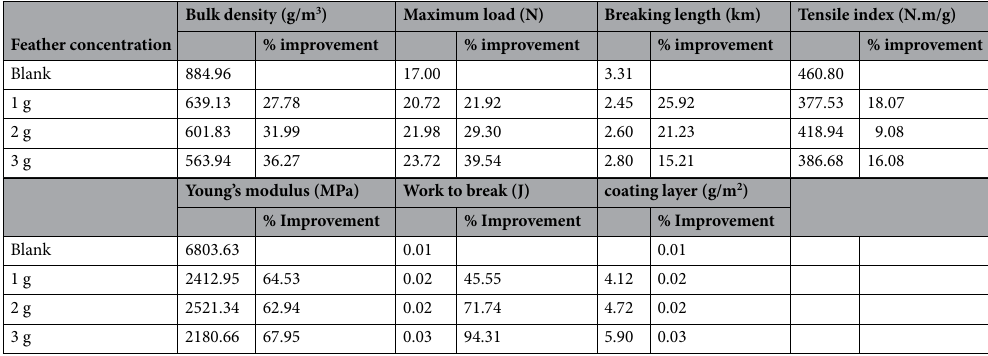
Bulk density (g/m 3 ) Maximum load (N) Breaking length (km) Tensile index Feather concentration